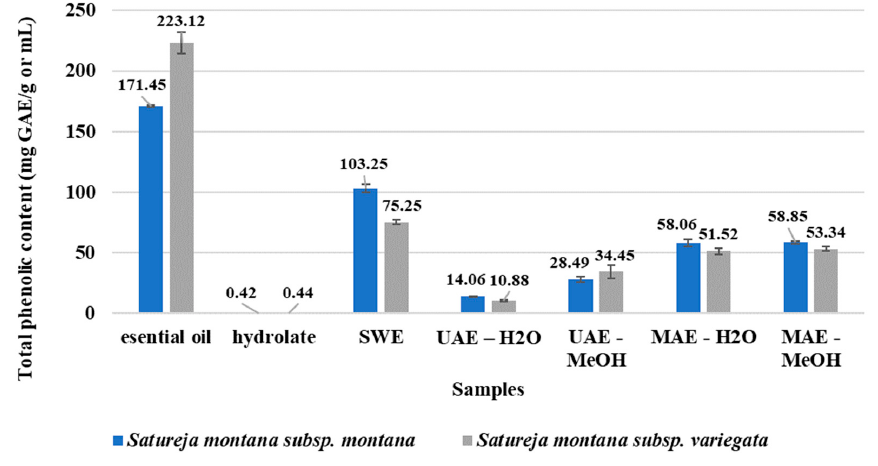
Figure 1. Total phenolic content.